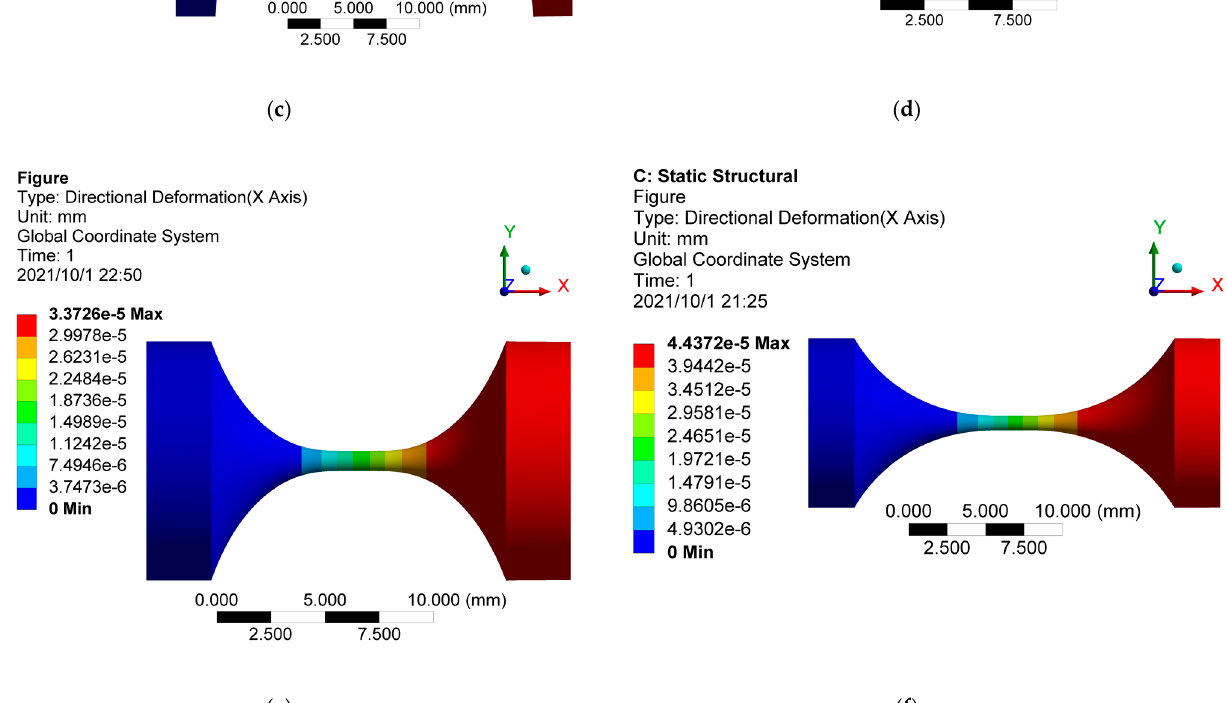
Figure 6. The x-directional displacement results of different notch types of flexure hinges: ( a ) Elliptical-beam; ( b ) Elliptical-